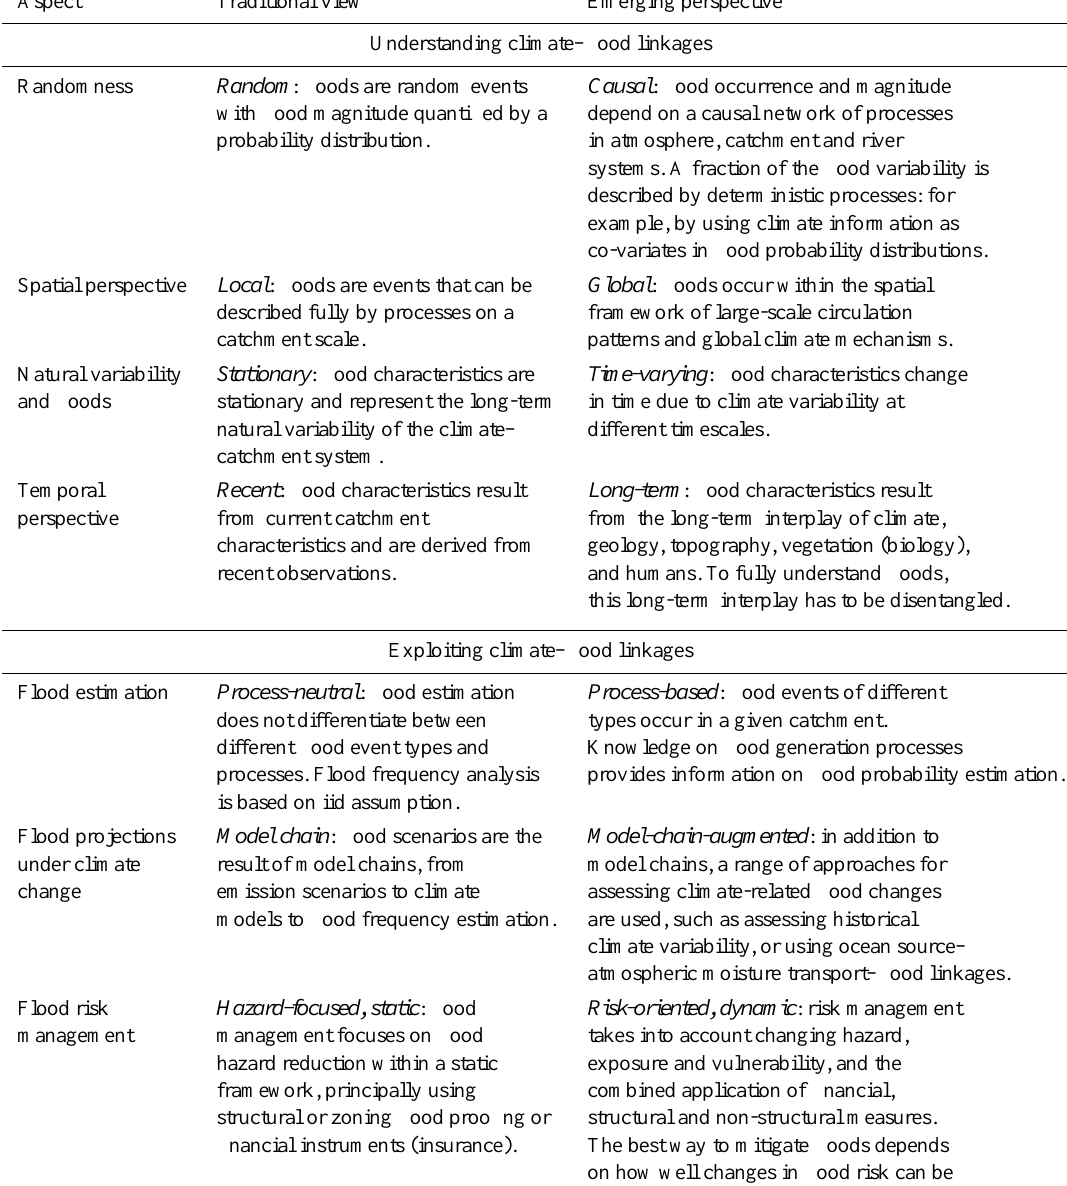
Table 1. Contrasting traditional views with emerging perspectives on flood hazard and